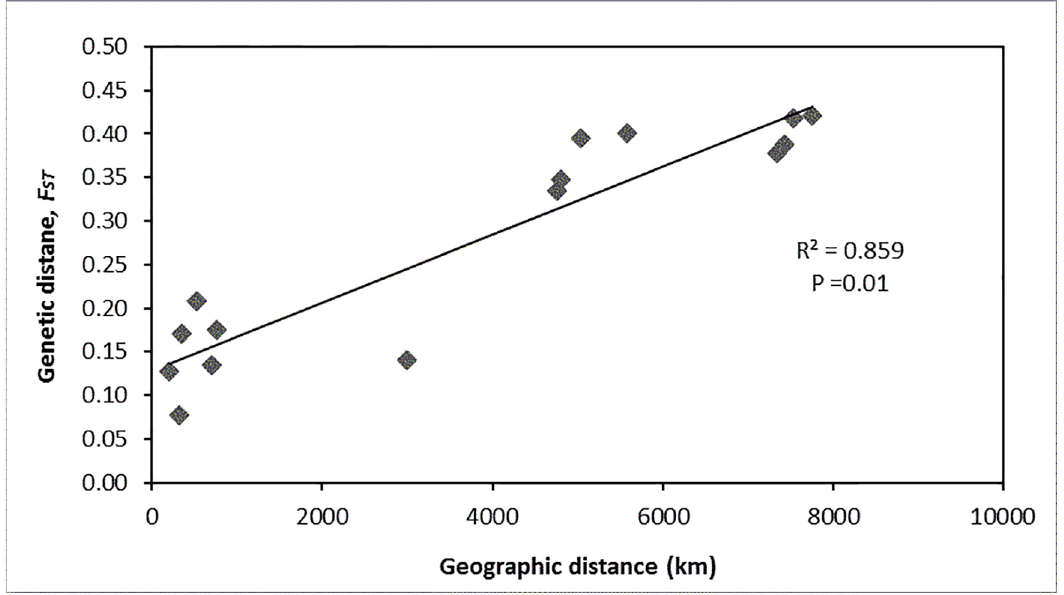
Fig 2. Mantels test comparing geographic (km) and genetic ( F locations in West and East Africa (n =